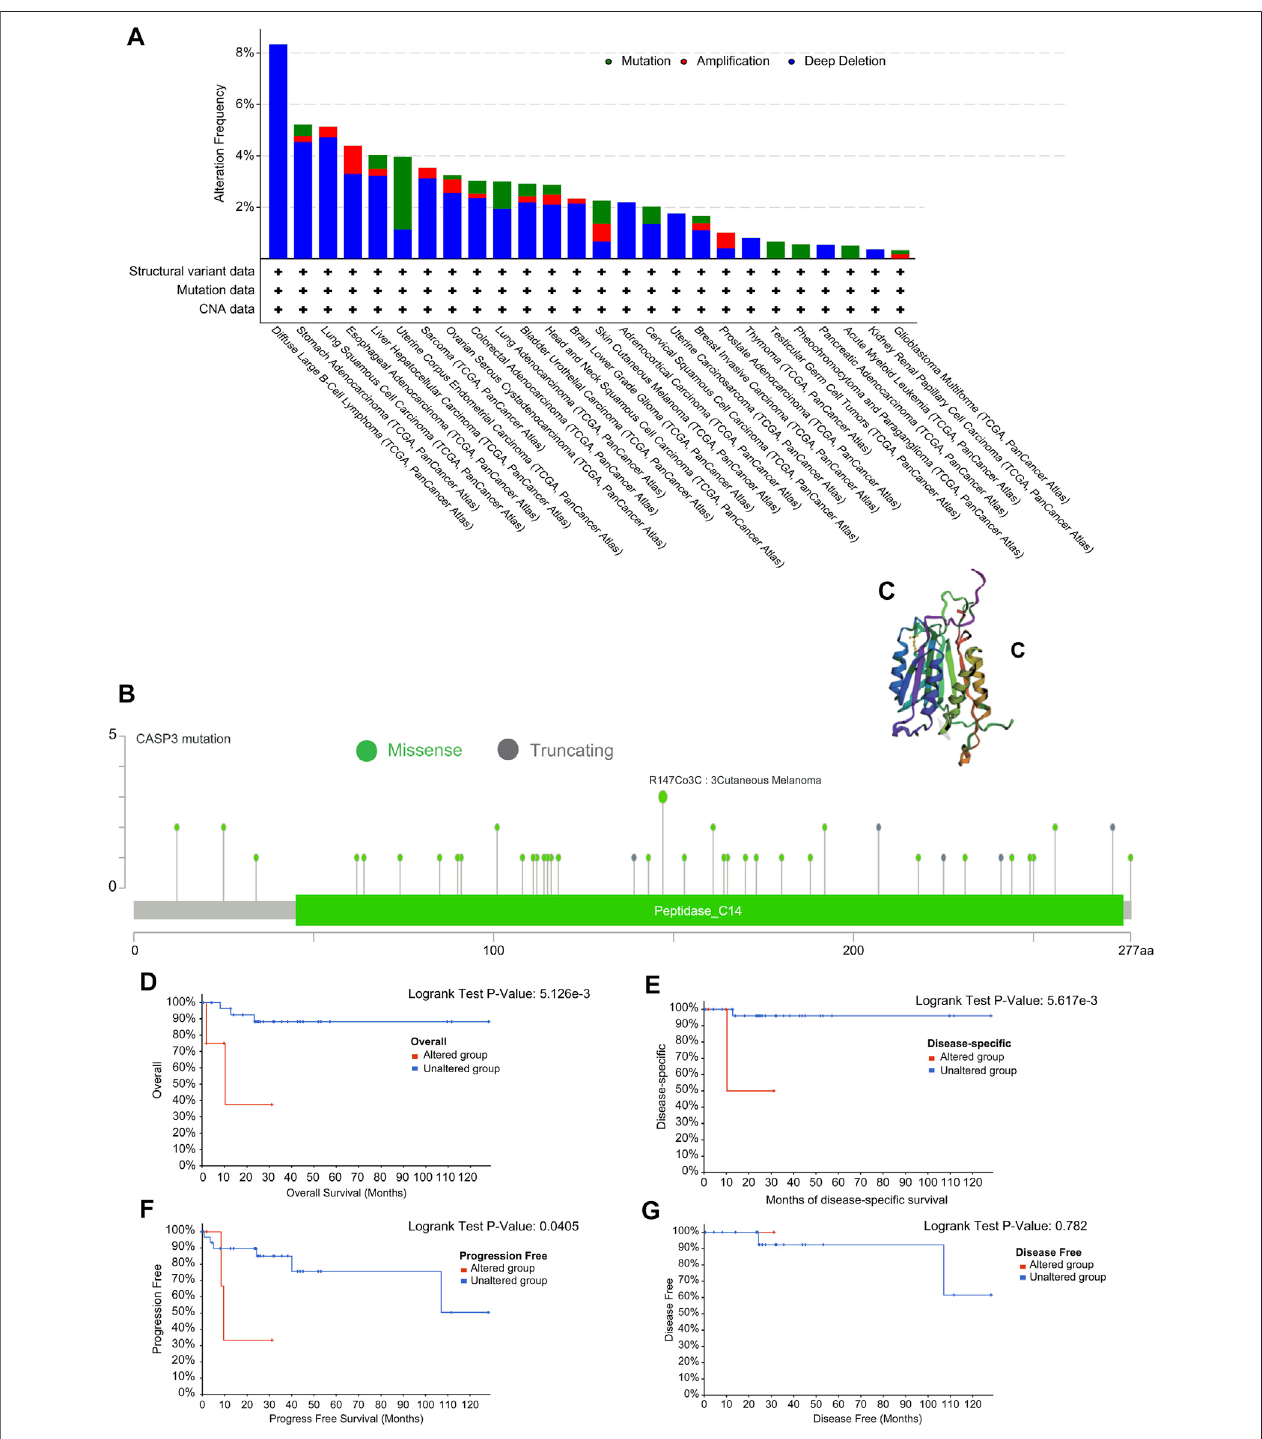
FIGURE6| Mutationcharacteristics of CASP3 geneindifferenttumours. (A) Types ofmutations of CASP3 indifferenttumours. (B) Frequencyof CASP3 mutation in different tumours. (C) Display the mutation site with the highest change frequency in the 3D structure of CASP3 . (D – G) Relationship between CASP3 mutation status and OS, DSS, DFI, PFI in DLBC by Kaplan-Meier survival analysis.